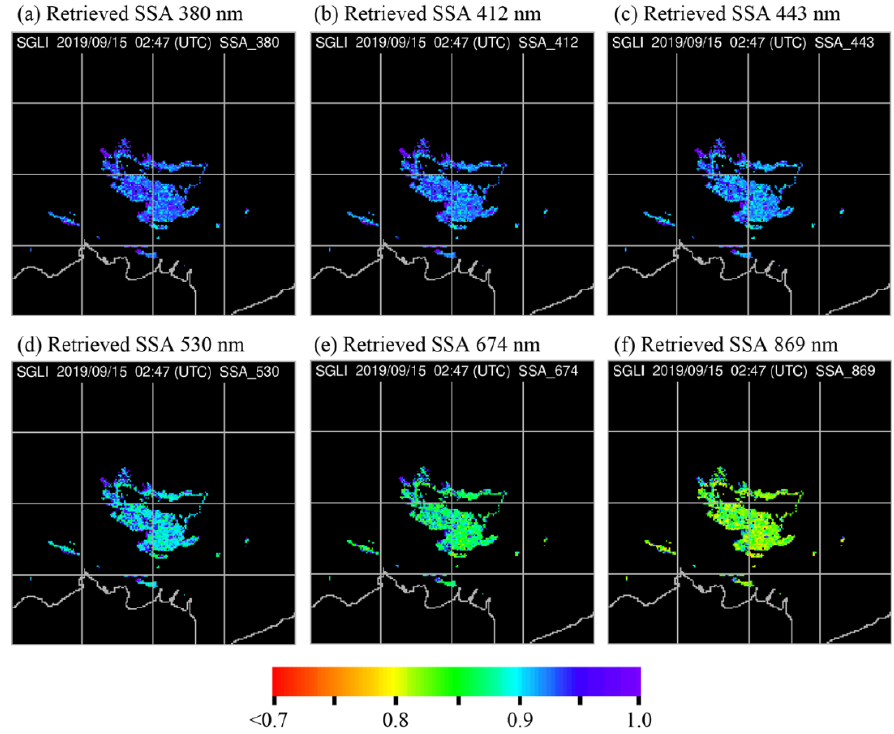
Figure 9. Single scattering albedo (SSA) retrieved from the second-generation global imager (SGLI) data on 15 September 2019 at 380 nm ( a ), 412 nm ( b ), 443 nm ( c ), 530 nm ( d ), 674 nm ( e ) and 869 nm ( f ).